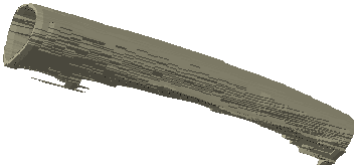
Fig. 12: 3D-view of segmented